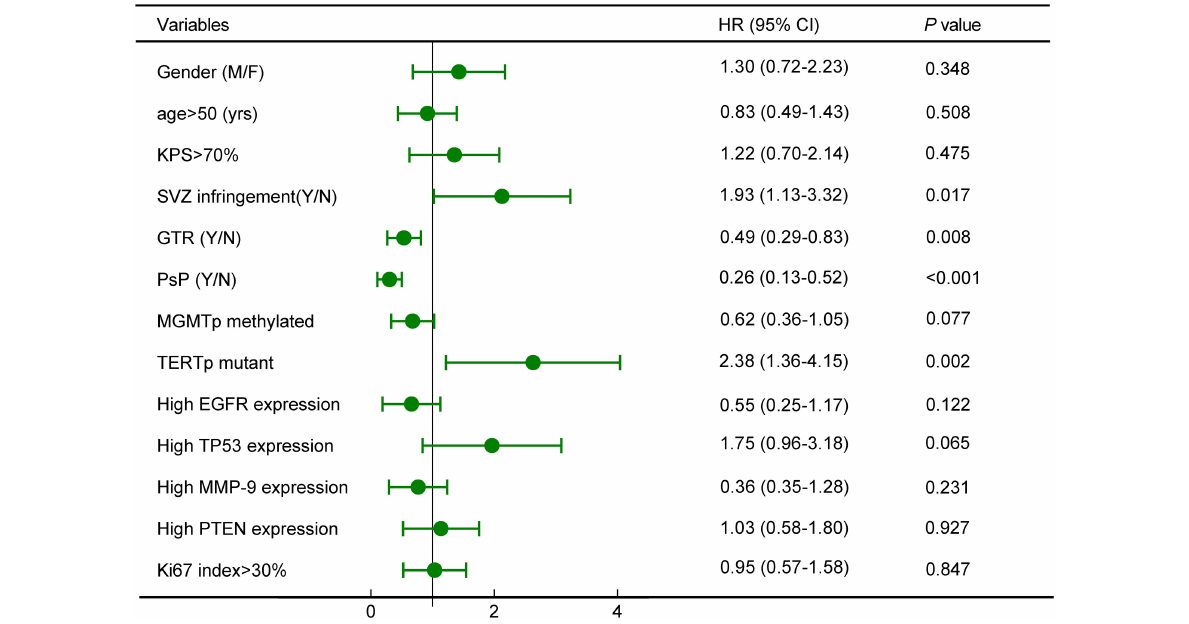
FIGURE 5 | Survival analysis revealed that subventricular zone (SVZ) infringement, gross total removal (GTR), PsP, and TERTp mutation were independent prognostic factors for